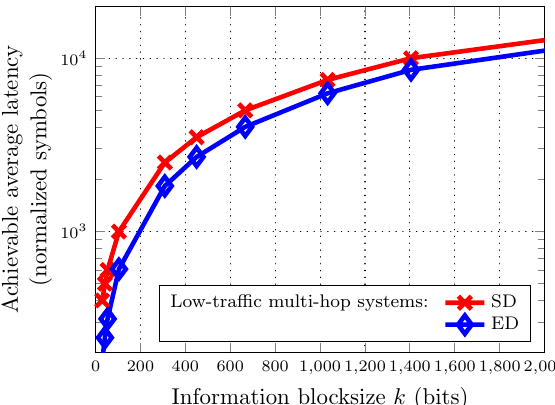
Fig. 10 Optimal achievable average latency of low‑traffic multi‑hop systems using either synchronous detection (SD) or early detection (ED). The number of hops h = 5 , the BLER ǫ = 10 − 5 , and the signal‑to‑noise ratio (SNR) is 5